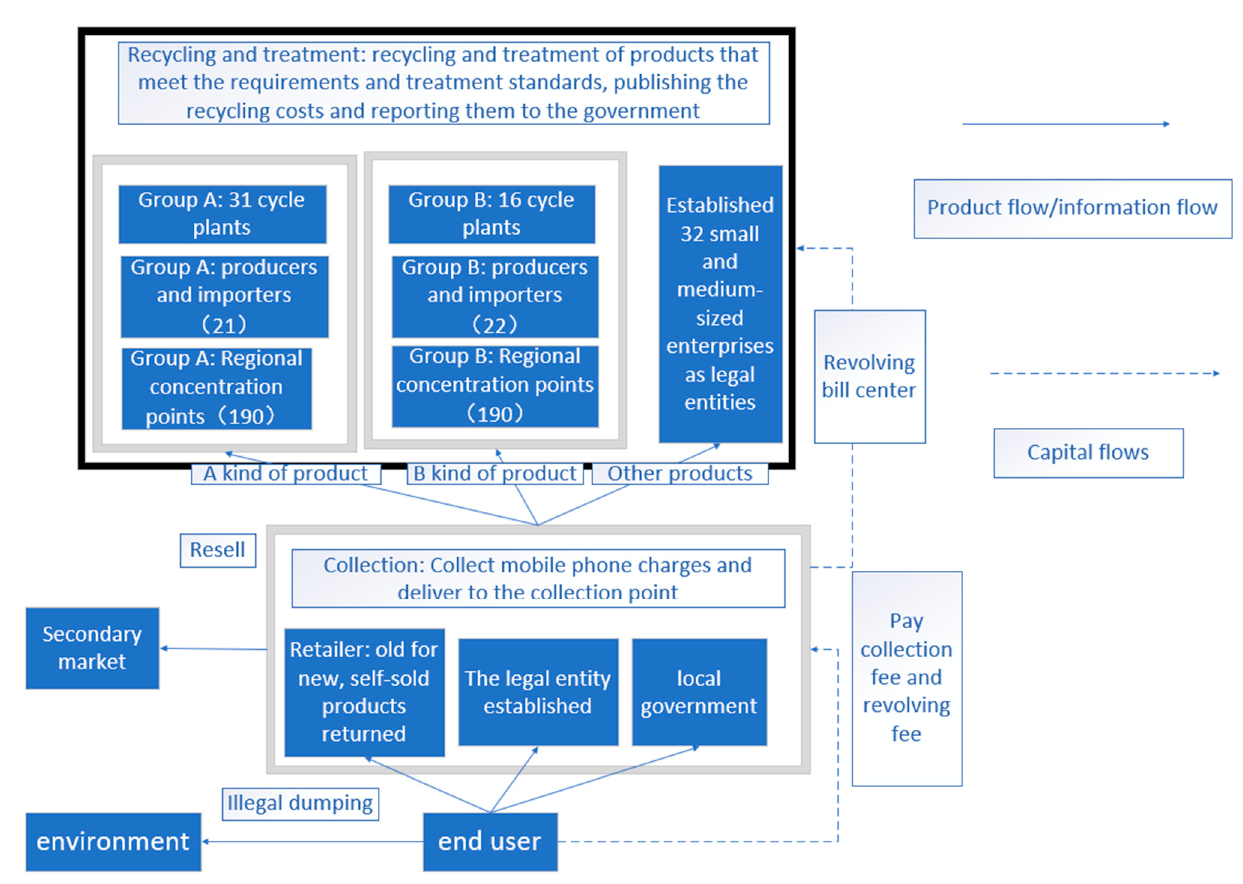
Figure 2. Operation mode of the fund policy in Japan (concluded from [30,31]).